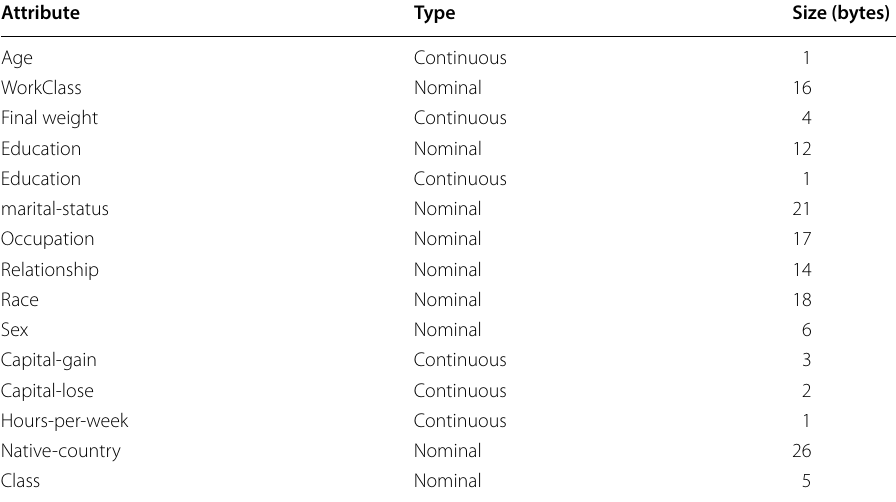
Table 25 Adult description (UCI,